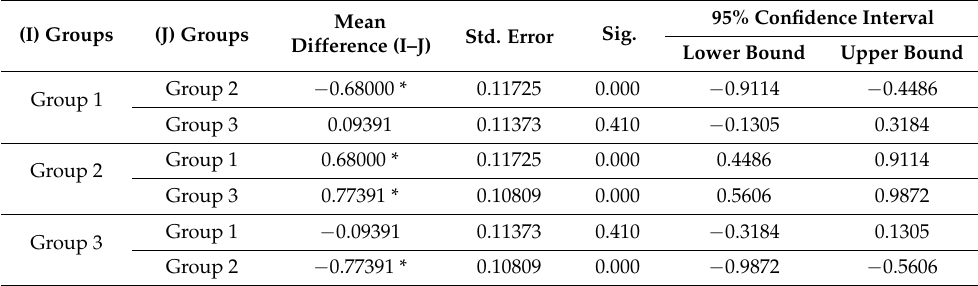
Table 5. Multiple